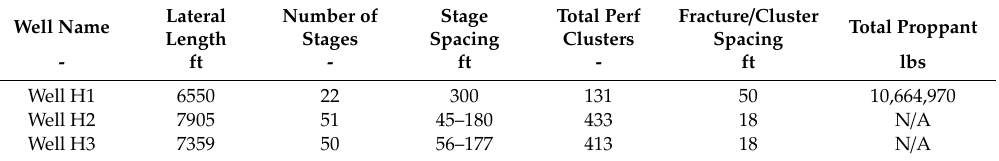
Table 1. E ff ective lateral length, fracture spacing, fracture number, and total proppant injected for the Eagle Ford Wells H1, H2, and